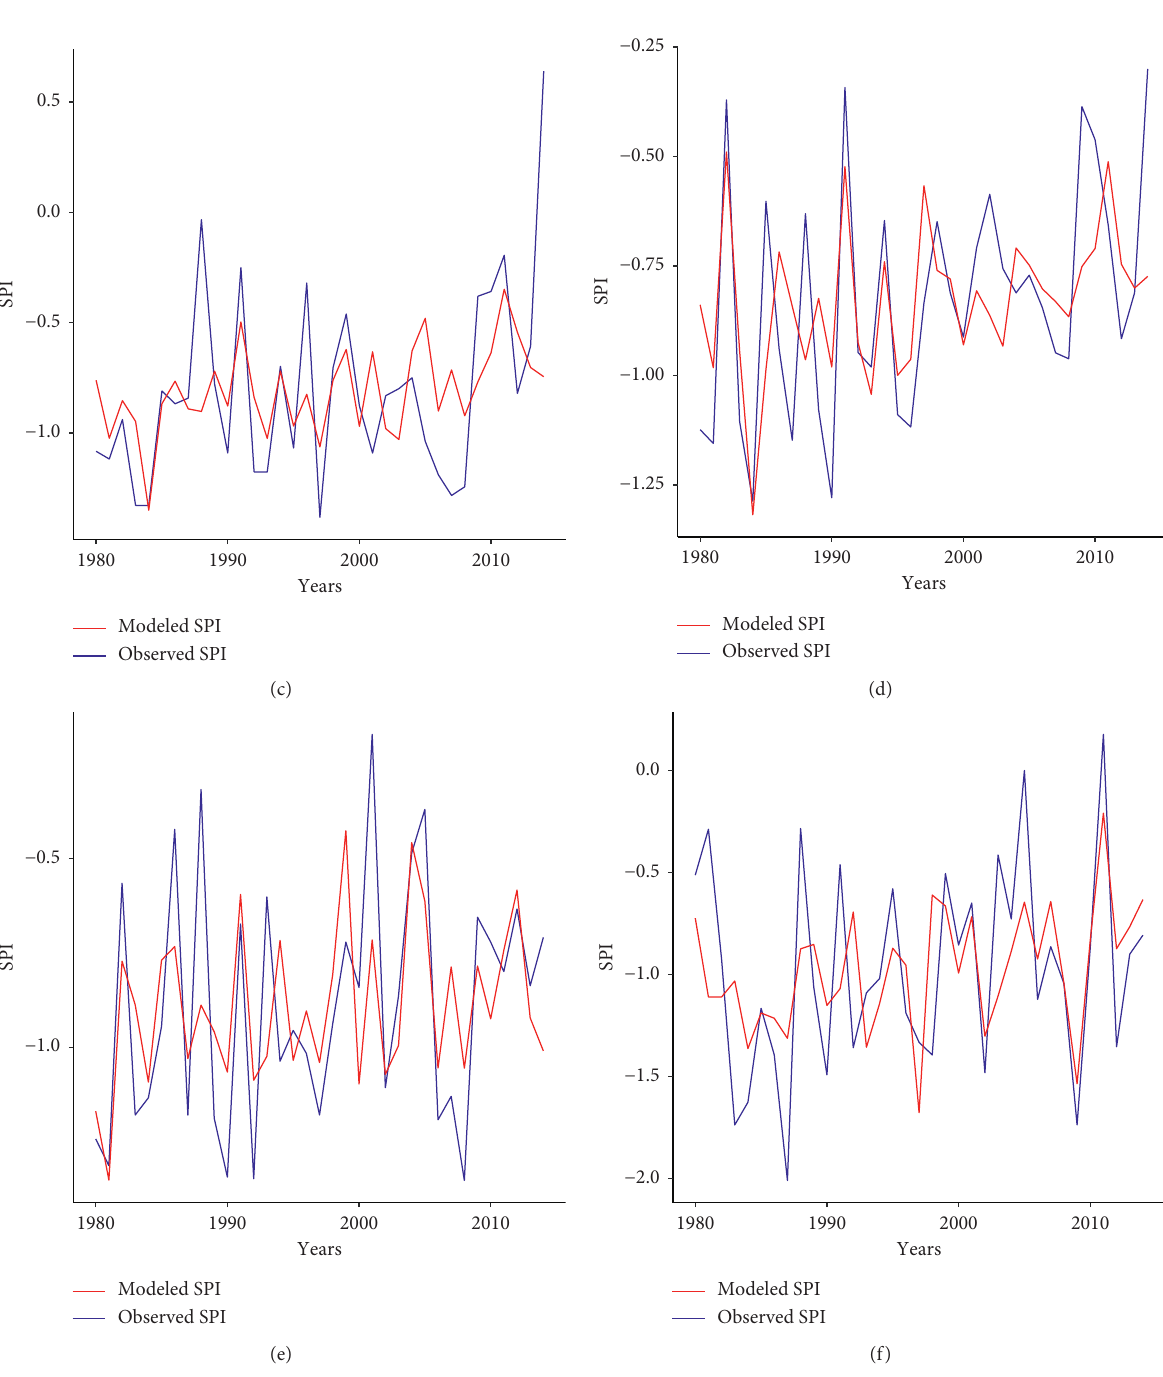
Figure 6: ComparisonbetweenmodeledDJFSPIbasedonNDJclimateindicesandobservedDJF SPIfor(a)Accra,(b)Ada,(c)Tema,(d)Saltpond, (e) Takoradi, and (f) Axim meteorological stations at timescale of drought periods. The observed SPI is in blue and red is